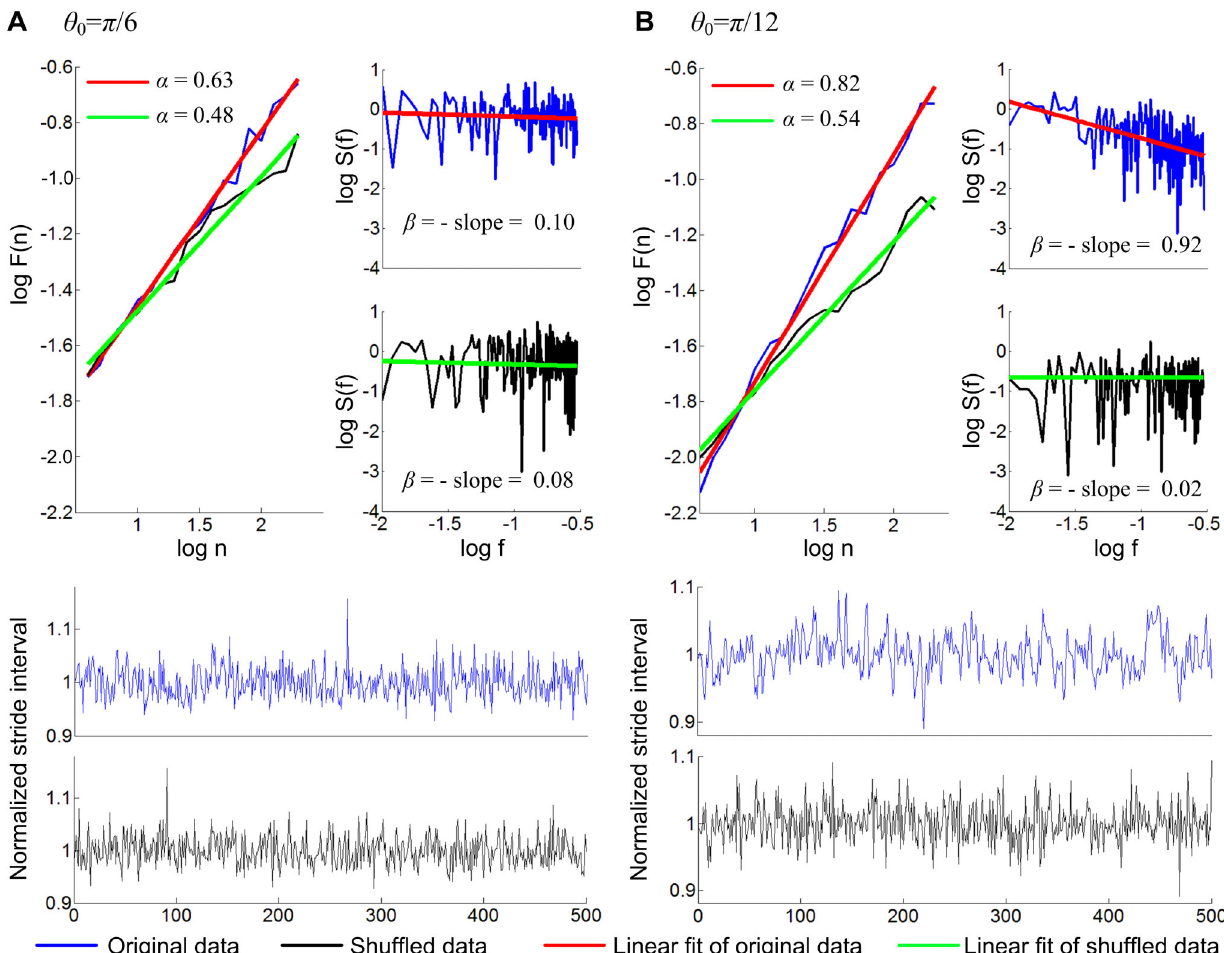
Figure 4. Scaling exponents a and b for 500 strides of walking with two different values of h 0 . The leading leg angle h 0 defines the Floquet multiplier as cos 2 2 h 0 , and determines how fast the perturbed dynamics converges to the nominal limit cycle. Small h 0 makes the Floquet multiplier close to unity yielding slow convergence, and large h 0 makes the Floquet multiplier close to zero yielding fast convergence. Both a and b are slightly different from those of the shuffled data with no correlation when h 0 is p /6 and the model yields relatively strong orbital stability (Floquet multiplier=0.25). The difference in the scaling exponents between the original time series and their shuffled counterparts becomes much more prominent when h 0 is p /12 and the attraction to the limit cycle becomes relatively weak (Floquet multiplier=0.75); a and b become similar to those of human walking with long-range correlations with clear difference from those of the shuffled data. The bottom panels show time series of the normalized stride intervals (stride intervals divided by their mean value). The structure of the time series changed due to shuffling particularly when h 0 is p /12.